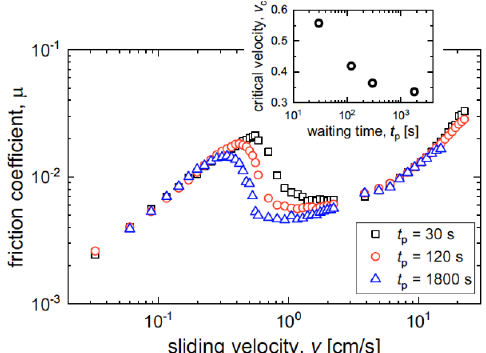
Figure 8. Friction as a function of sliding velocity for a commercial polyacrylic hydrogel particle sliding on a PAAm hydrogel surface. Three different values of the experimental running time are shown to illustrate the influence of time on the frictional response. Inset shows that the value of the critical velocity at which the peak in friction is observed decreases with increasing contact time [29]. The initial increase in friction with V is attributed to flow through the hydrogel, and the response at the highest sliding velocities is associated with full fluid film lubrication. Reprinted with permission from Cuccia, N.L. et al., Pore-size dependence and slow relaxation of hydrogel friction on smooth surfaces.